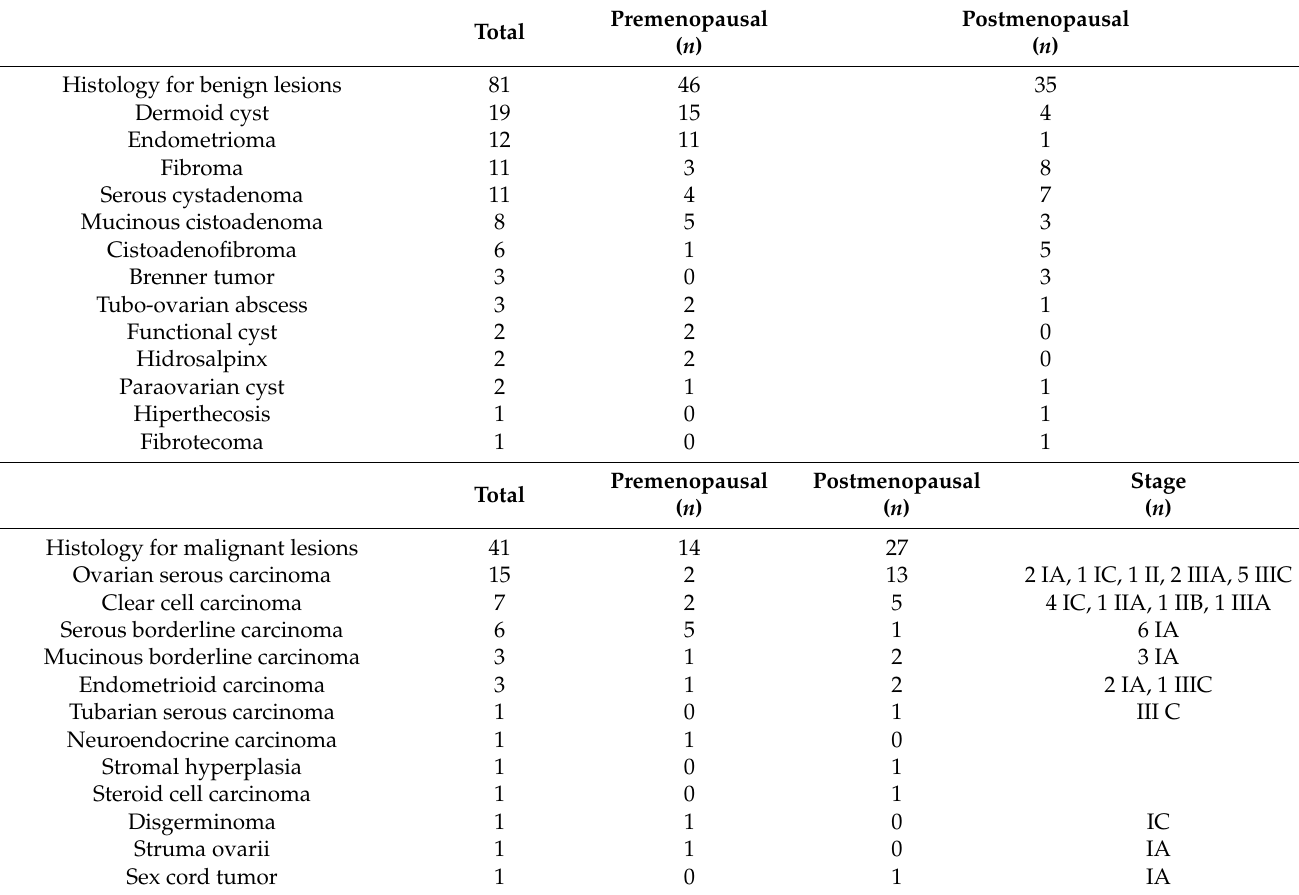
Table 4. Histologic diagnosis of benign